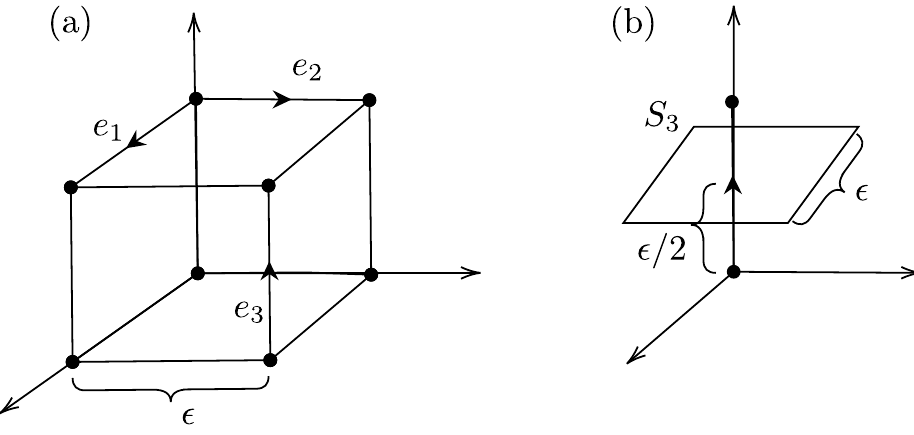
Figure 1. ( a ) Building block for the decomposition of the 3-geometry. ( b ) Example of one of the smearing surfaces to calculate the